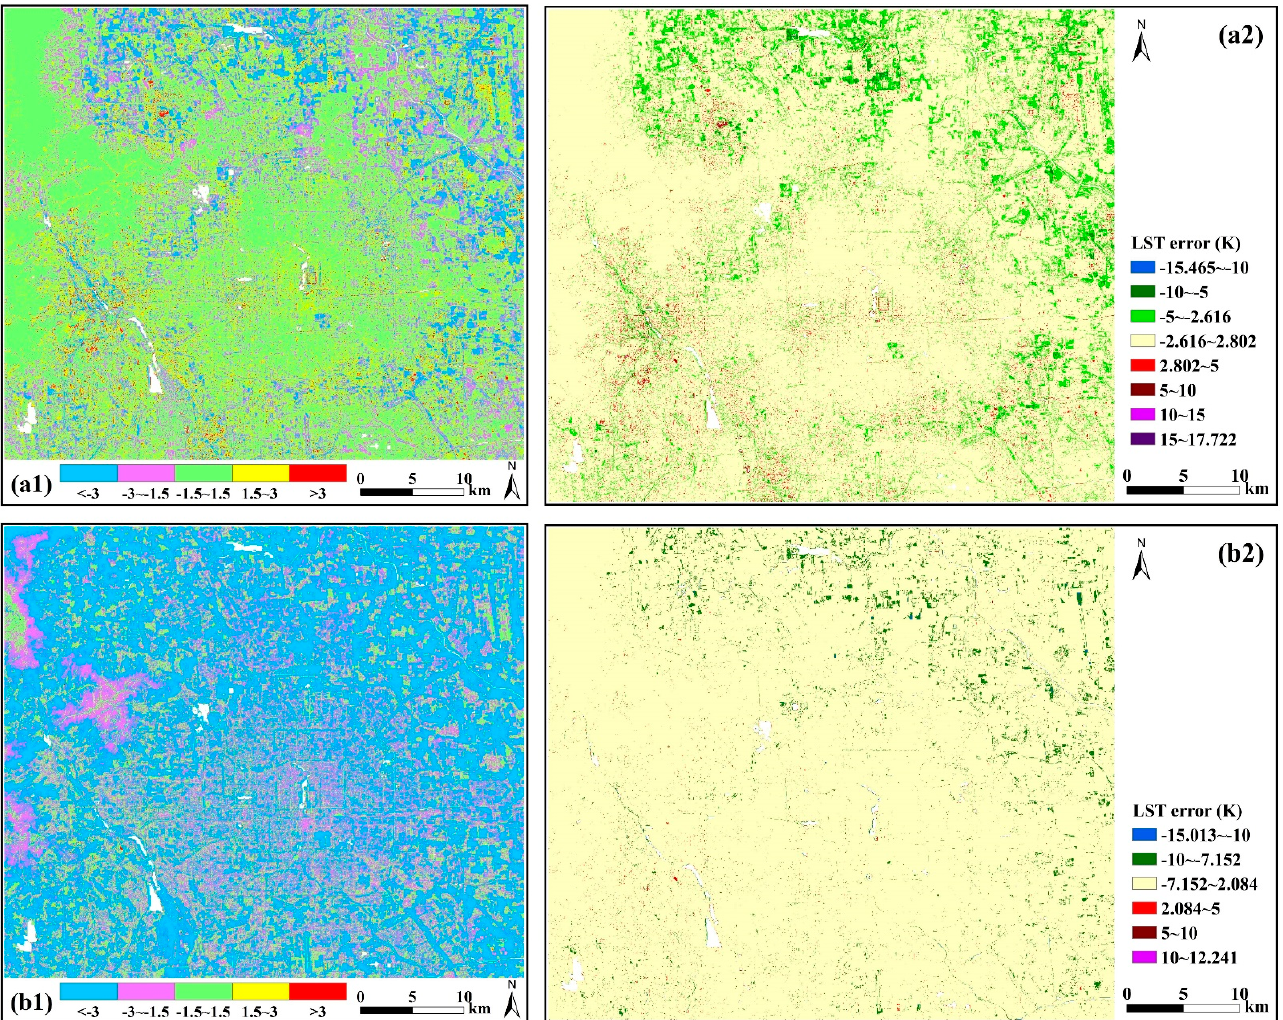
Figure 10. Spatial distribution of LST errors (K) in the MFGWML and TsHARP models for Scheme 1. Plots ( a1 , b1 ) represent the spatial distribution of LST errors for MFGWML and TsHARP, respectively. Plots ( a2 , b2 ) indicate LST error outliers for MFGWML and TsHARP, respectively. In the plots ( a2 , b2 ), different colors except the light yellow color indicate outliers with different error ranges. Table 8. Proportional values of LST errors in MFGWML and TsHARP for the six downscaling schemes performed in the entire city of Beijing (excluding water regions).